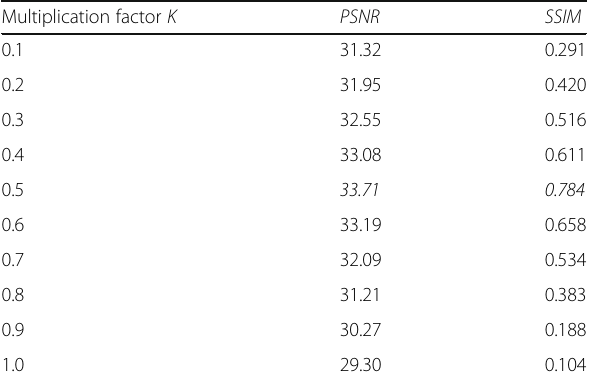
Table 1 Variation in average values of PSNR and SSIM with variation in multiplication factor K for TID2008 database at 80%